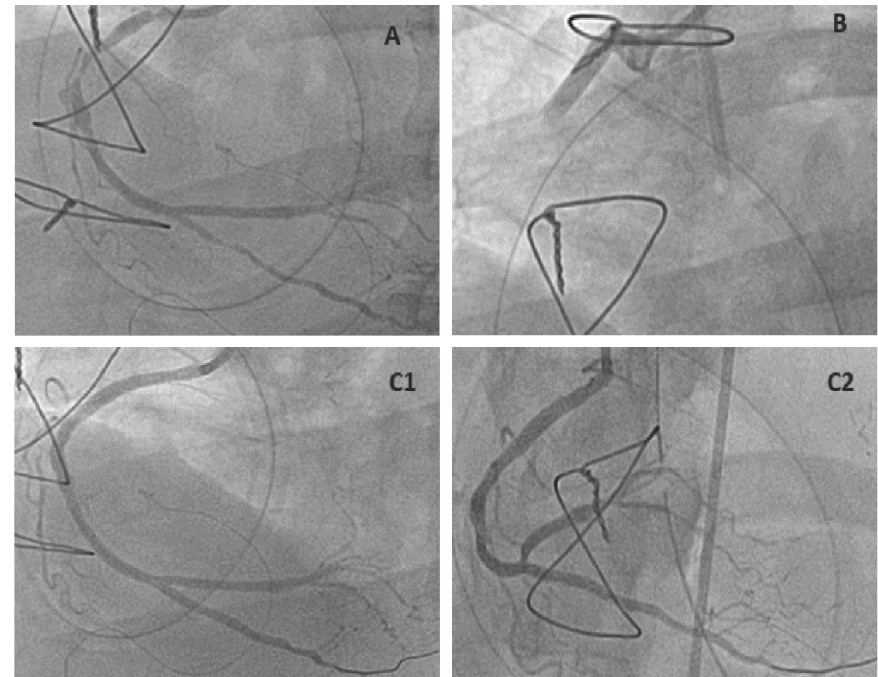
Figure 3: (a) Preoperative coronary angiogram showing RCA proximal significant stenosis and diseased proximal part of PDA. (b) The graft to RCA showed total occlusion (acute graft occlusion). (c) RCA and PDA after PCI and